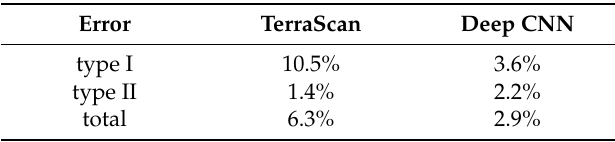
Table 2. Comparison of total error over 40 various complex terrains between TerraScan and deep CNN model.